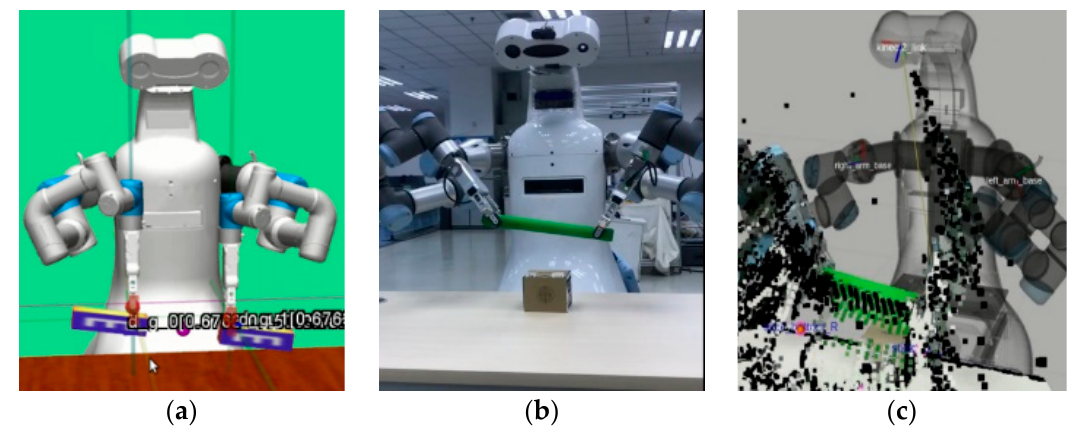
Figure 14. The problem of tilt for the thin rod. ( a ) Grab results in simulation environment. ( b ) Grasping effect of real robot. ( c ) The renderings in RVIZ.